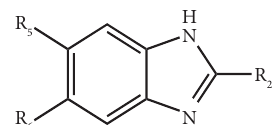
Figure 2: Basic trisubstituted benzimidazole